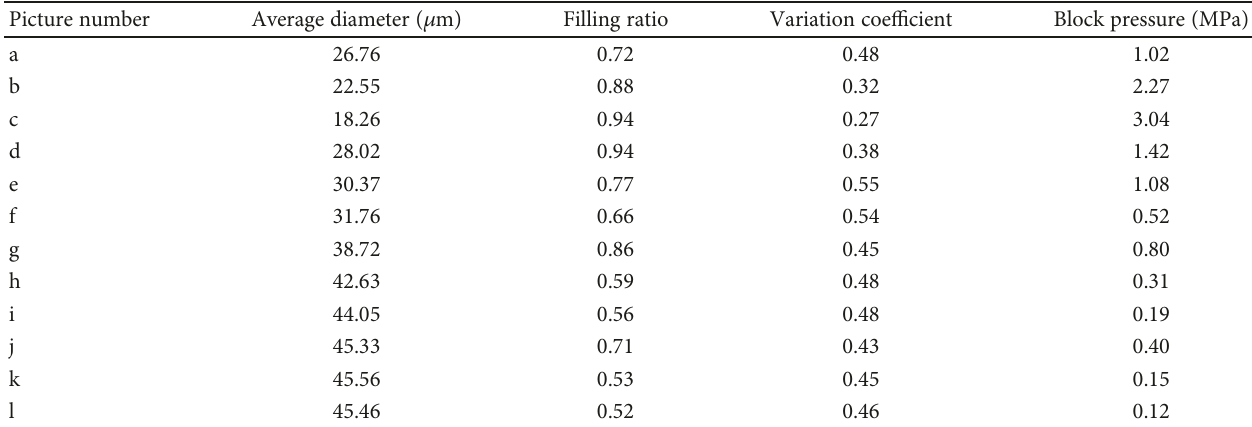
Figure 8: Foam texture observed in the micromodel at di ff erent positions and temperatures. Table 2: Foam texture parameters and its corresponding blocking